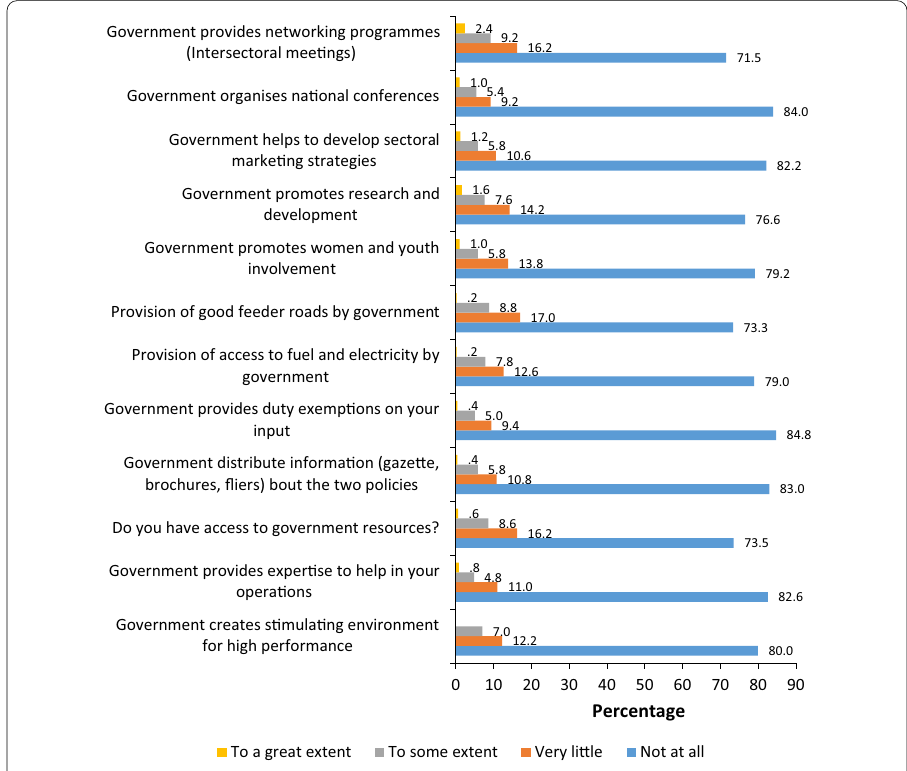
Fig. 3 Effects of government policies on SME performance (questionnaire